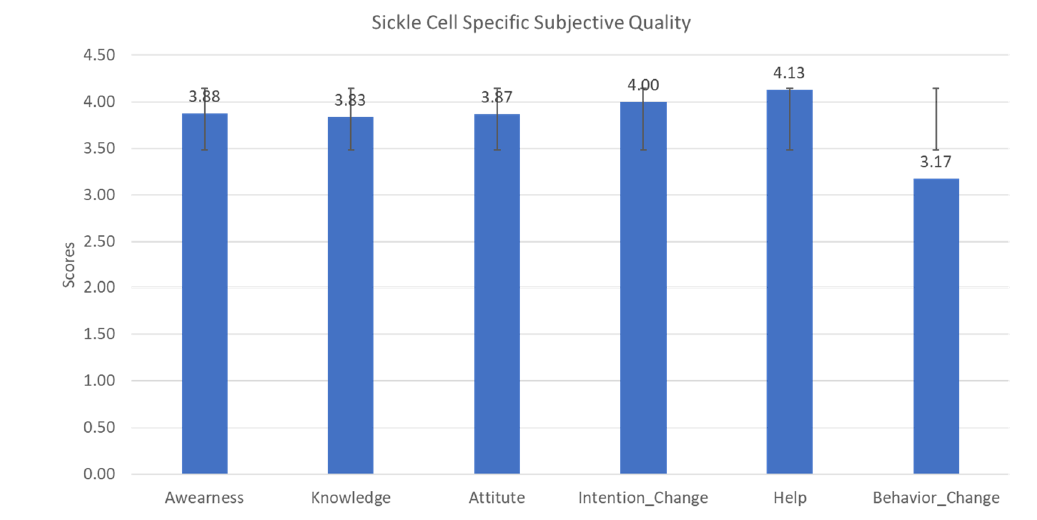
Figure 5. Sickle cell-specific application quality scale distribution.